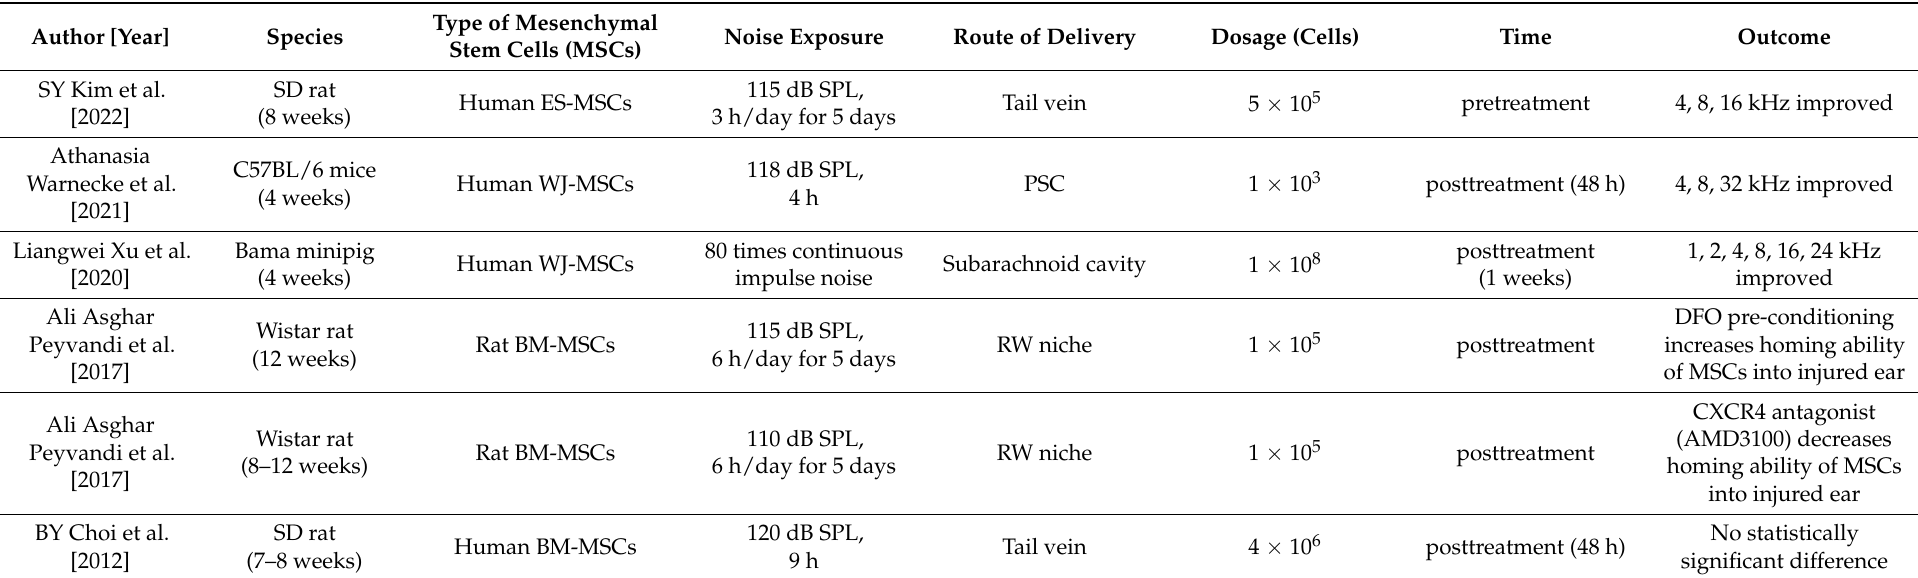
Table 1. In vivo studies of mesenchymal stem cells (MSCs) in noise-induced hearing